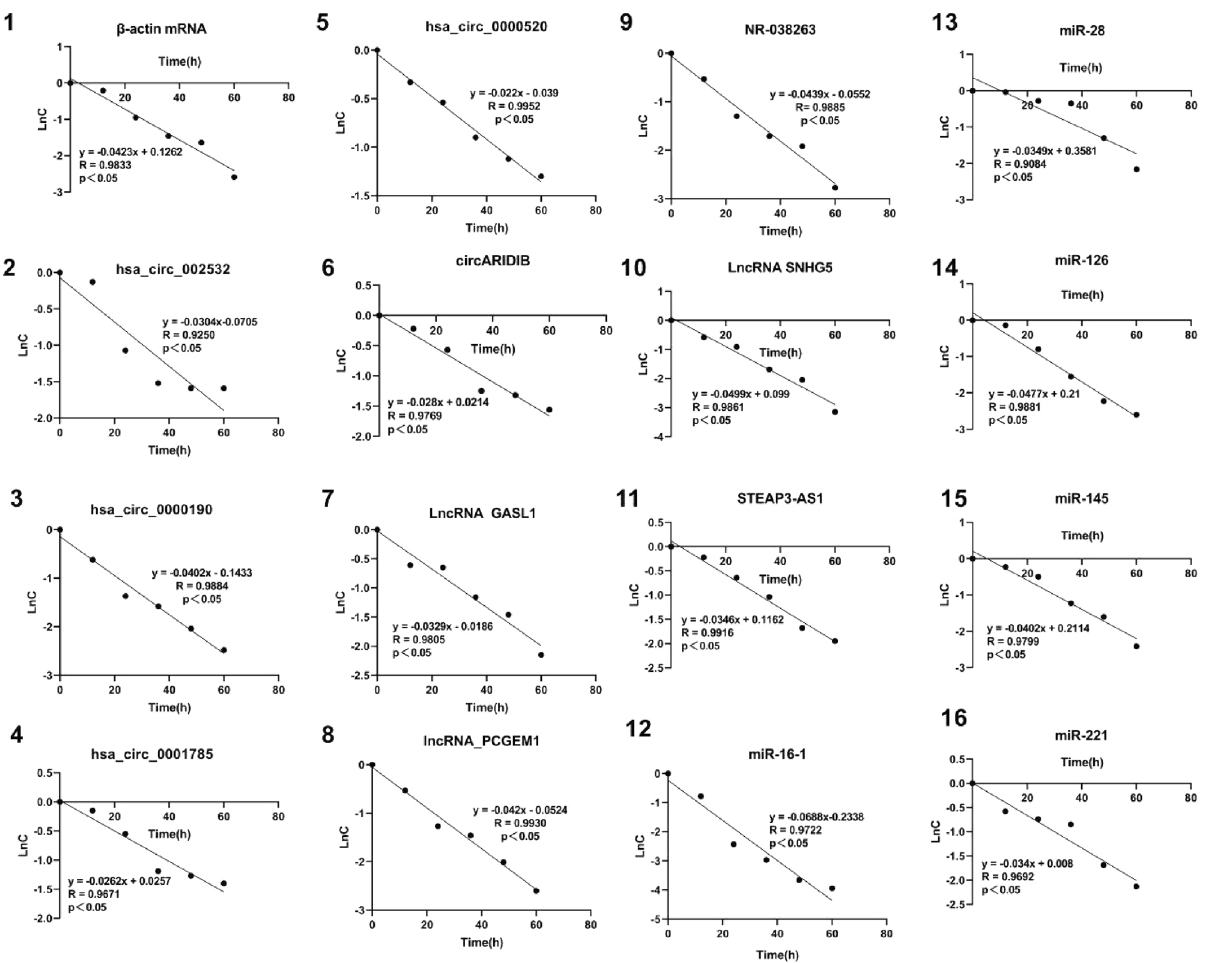
Figure 2. Dynamic degradation curves for mRNA, circRNAs, lncRNAs and miRNAs in blood after natural logarithm transformation.